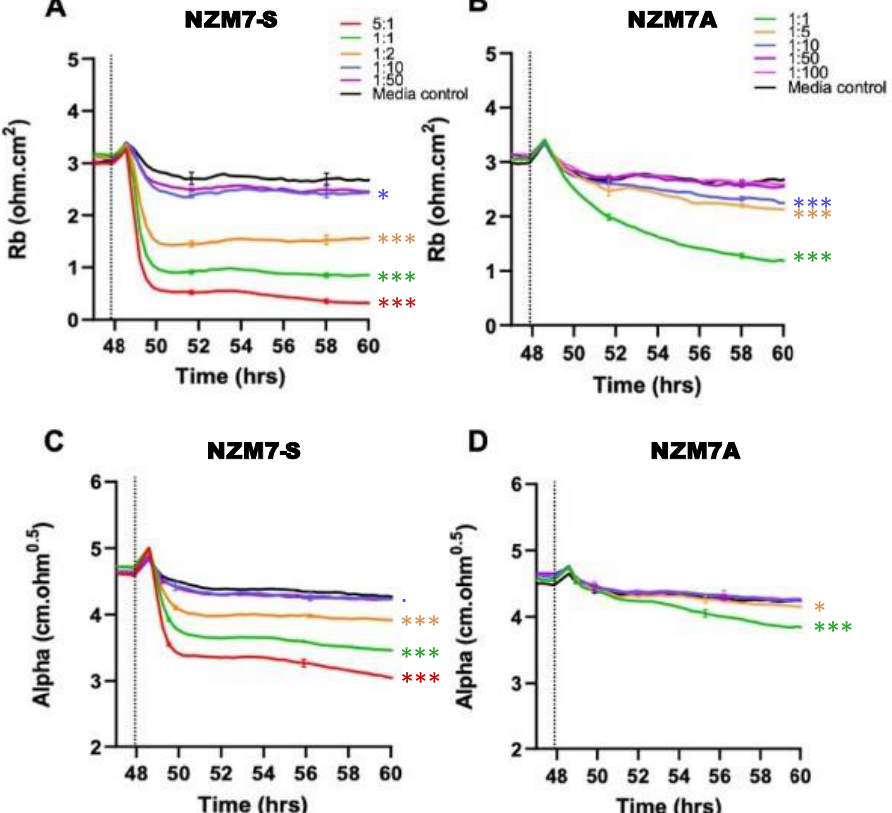
Figure 4. Melanoma-mediated disruption of the brain endothelium. Graphs ( A , B ) show modelled paracellular resistance (Rb) of hCMVECs after the addition of NZM7-S and NZM7A cell types, respectively. Graphs ( C , D ) show modelled basolateral resistance (Alpha) of hCMVECs after the addition of NZM7-S and NZM7A cell types, respectively. NZM7 cells were added at 48 h. The data show the mean ± SD ( n = 3 wells) from 1 experiment, which is representative of 4 independent experiments. The 60 h endpoints from independent experiments were compared relative to their media control using two-way ANOVA with Tukey’s range test ( . p < 0.1, * p < 0.05, *** p < 0.001).